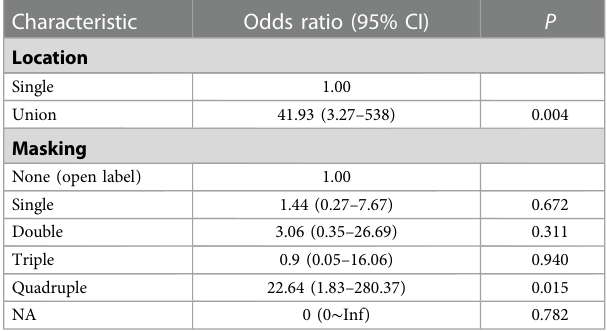
TABLE 3 Multivariate analysis associated with publication for clinical trials.